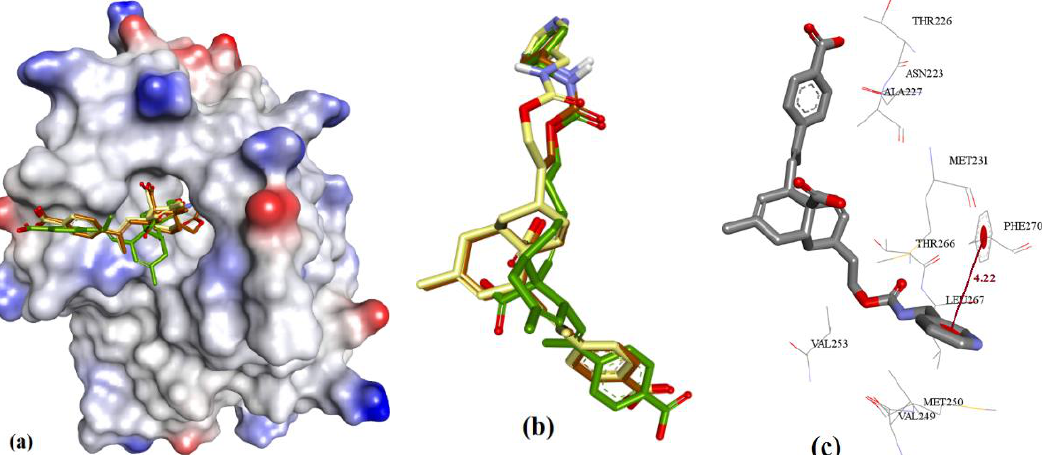
Figure 24. ( a ) The ionized solvent-exposed surface mapping of hMcl-1 along with the docked poses of 8c from MOE (in brown), AutoDock (in green), and VlifeDock (in yellow) show their fitting to the cavity. ( b ) Similar-pose ensemble clustering of all three poses was attained from the three different docking methods. ( c ) Binding mode of 8c.